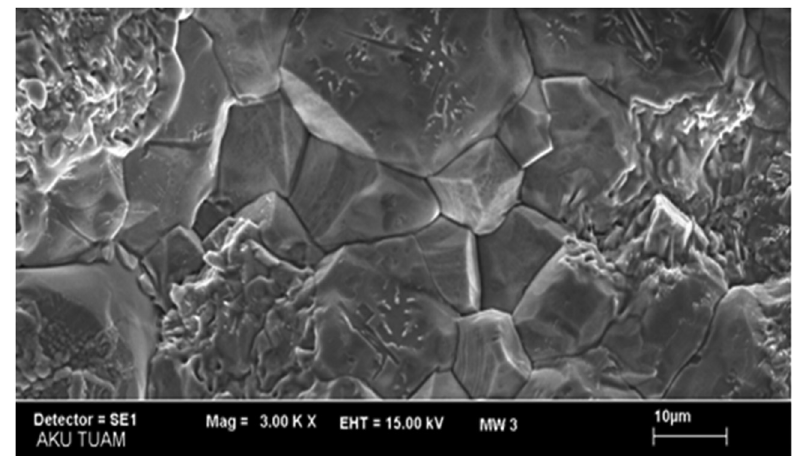
Figure 10: SEM micrographs of 25% Ni - coated Fe – 37.5% Co, Mag. 3k ×